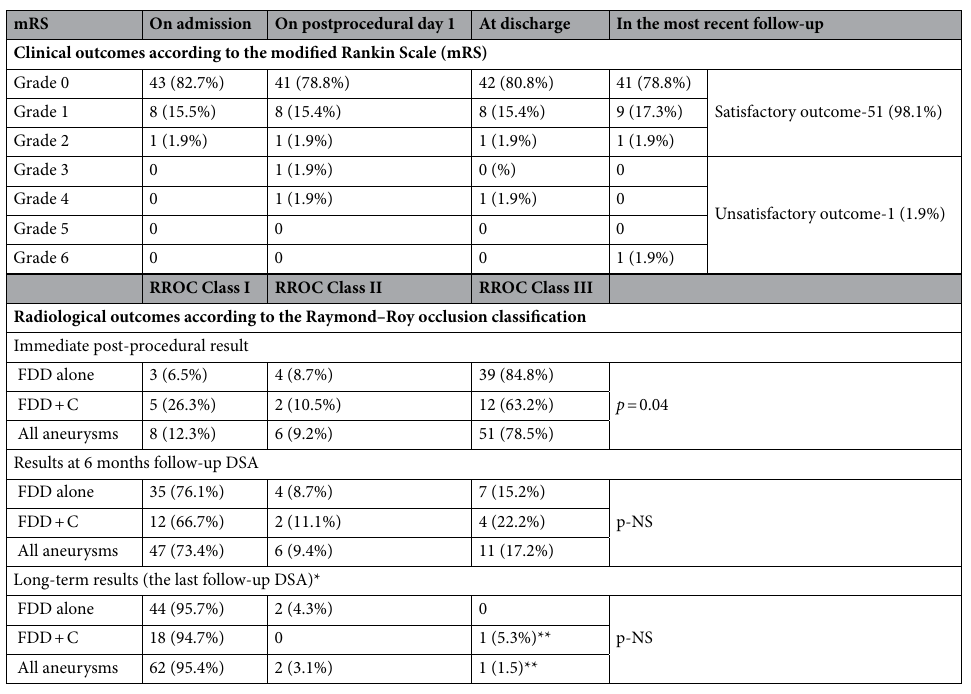
Table 2. Clinical and radiological outcomes. NS, not significant.*Include also results of retreatment. **In patient who died, the last DSA performed after SAH revealed a critical distal end stent stenosis and aneurysm remnant (RROC class III, OKM